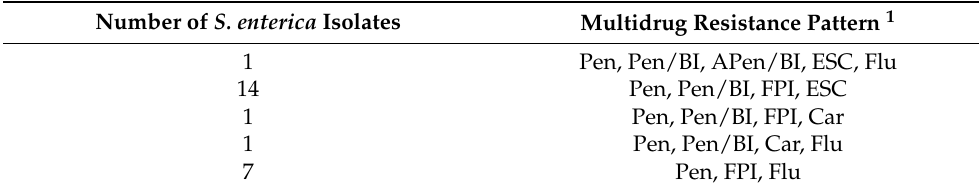
Table 3. Multidrug resistance patterns of 24 S. enterica